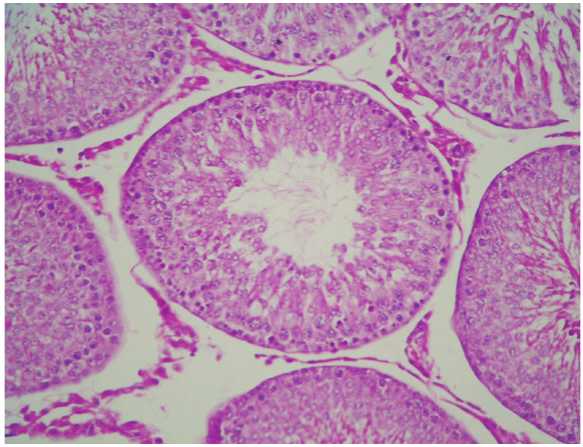
Figure 2b - Spermatogonia, spermatocytes and many early spermatids are seen. No late spermatids and spermatozoa are present (H-E,